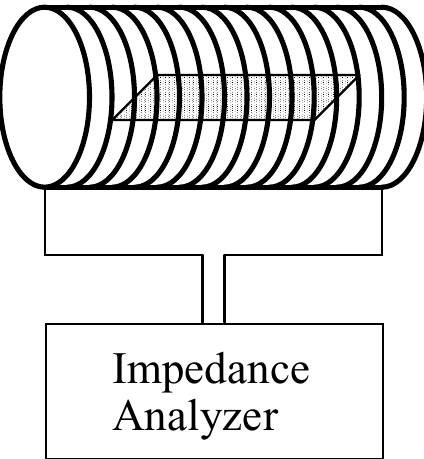
Figure 8. The magnetoelastic sensor can be detected by placing inside a solenoid and measuring the impedance variation of the